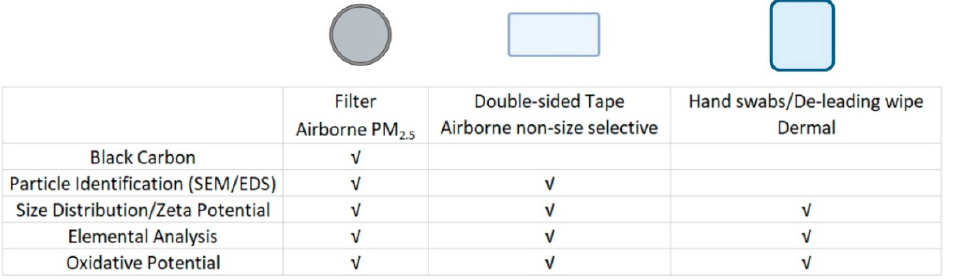
Figure 1. Sample Flow Chart. The flow chart summarizes all of the analysis processes done to each of the sample types.